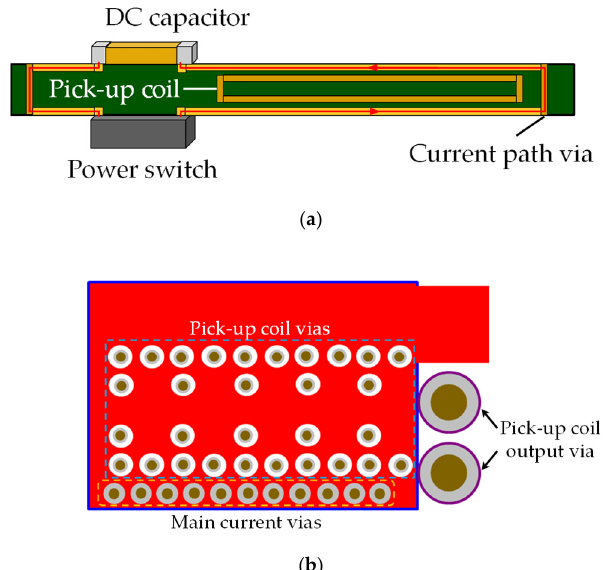
Figure 11. Structure of PCB with proposed pick-up coil: ( a ) side view; ( b ) top view.